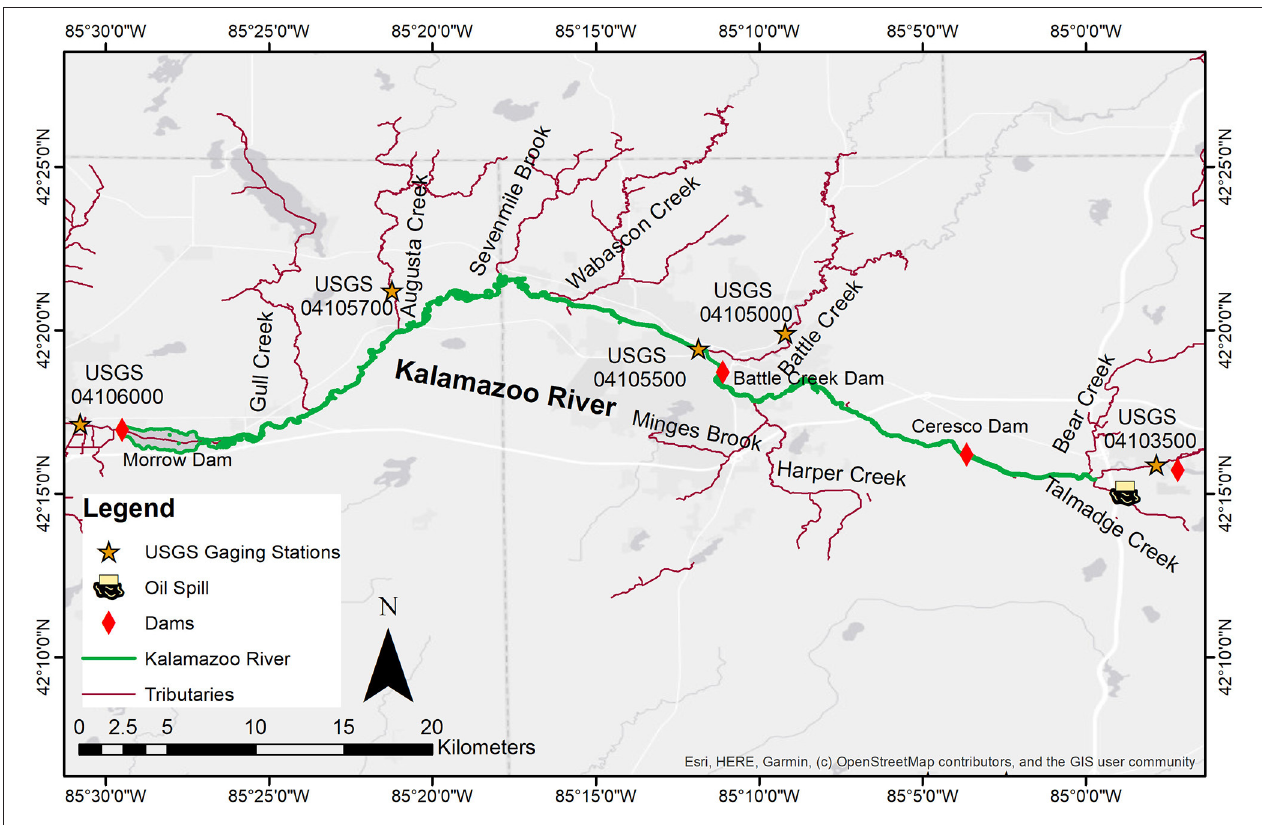
FIGURE 4 | The Kalamazoo River study domain, tributaries, and U.S. Geological Survey gaging